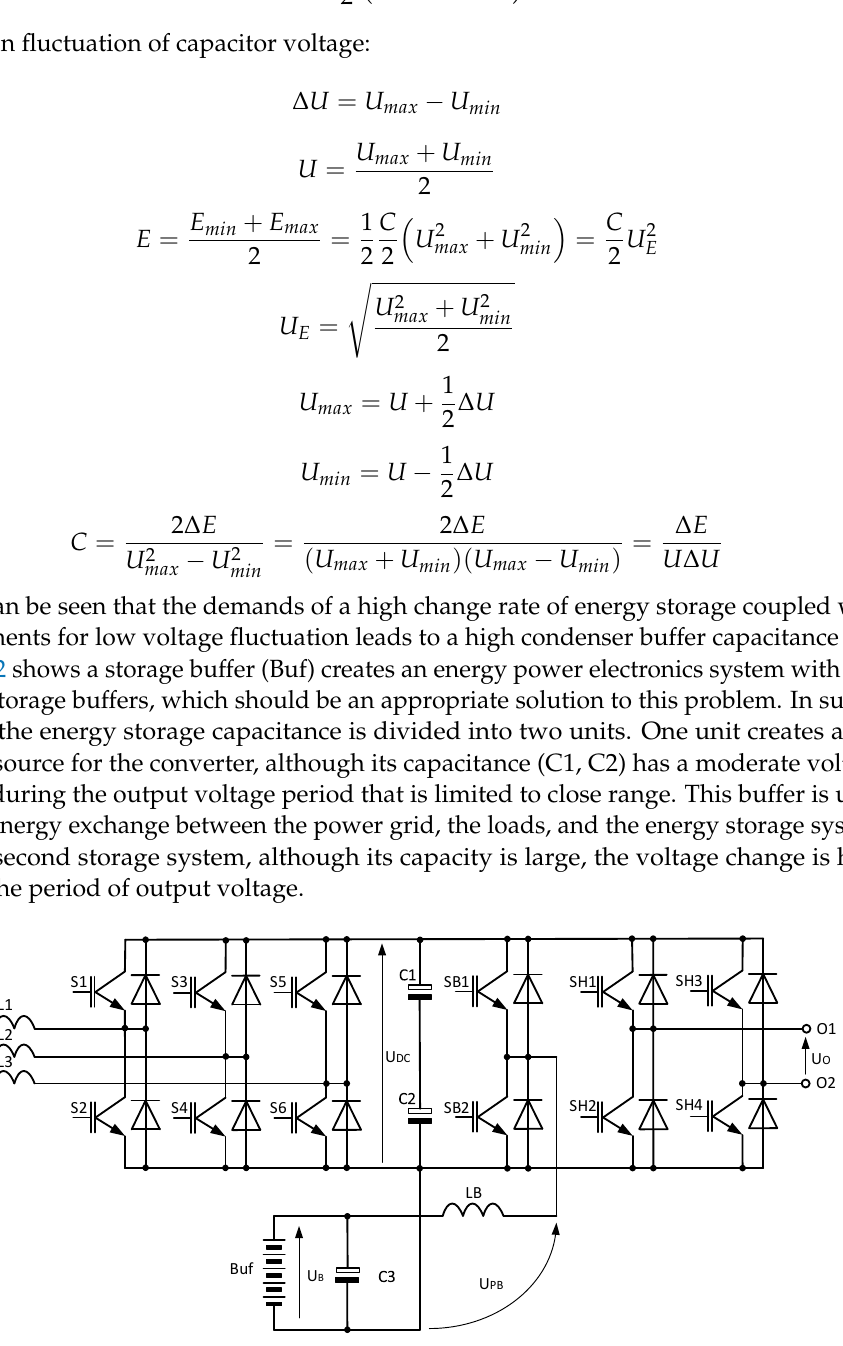
Figure 12. Configurations of the power electronic part of the de-icing system.